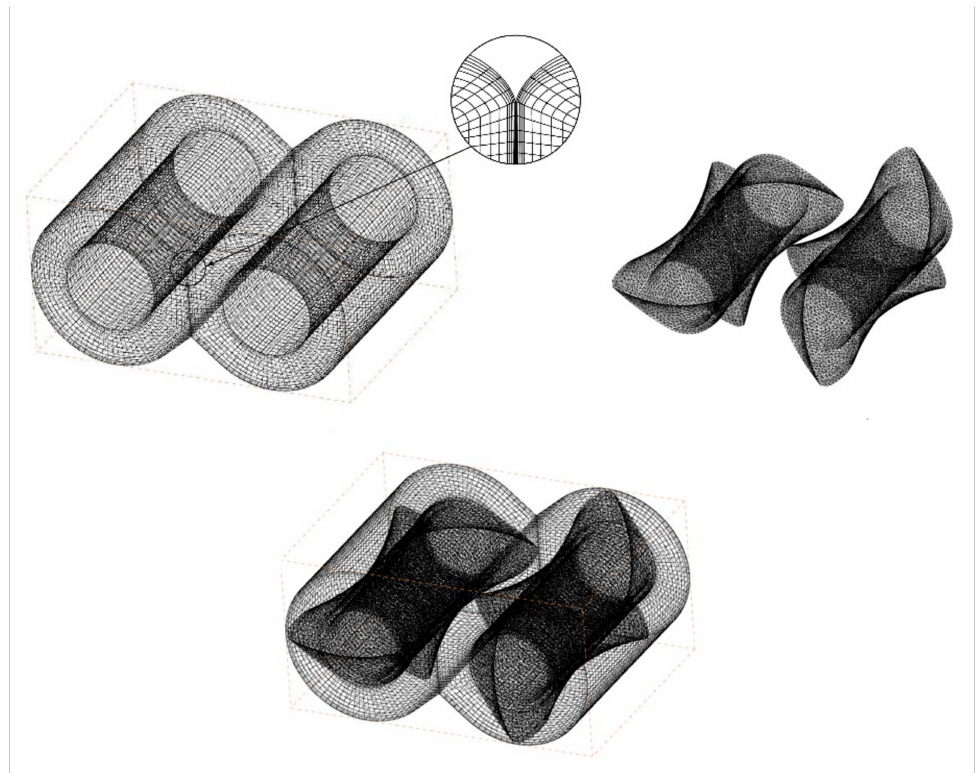
Figure 4. Finite element meshing with